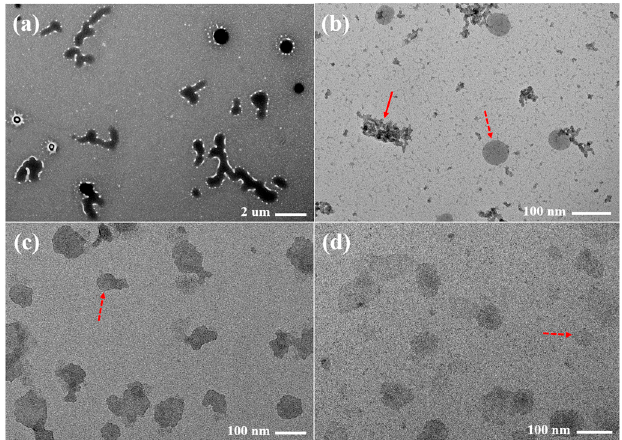
Figure 7. Transmission electron microscopy (TEM) images of raw PZH ( a ) dispersed in water, FCS11 ( b ), FCS14 ( c ), and FCS18 ( d ) dispersed in pH 6.8 buffer with 1% polysorbate 80.